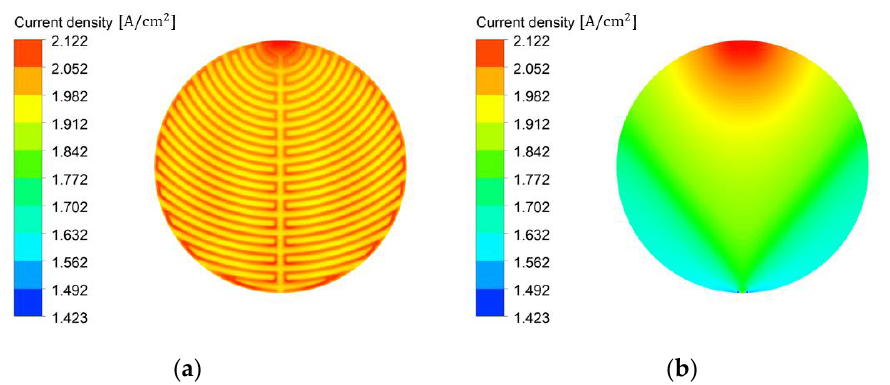
Figure 10. Current density distribution on the active area using ( a ) the channel flow field and ( b ) the PTL flow field of PEMWE ( ε : 0.75, K : 30.2 × 10 −12 m 2 , θ : 30°, 𝑄̇ 𝑖𝑛 : 10 sccm, T in : 328.15 K, T cell : 328.15 K, V op : 1.8 V and 𝑔 : z+).